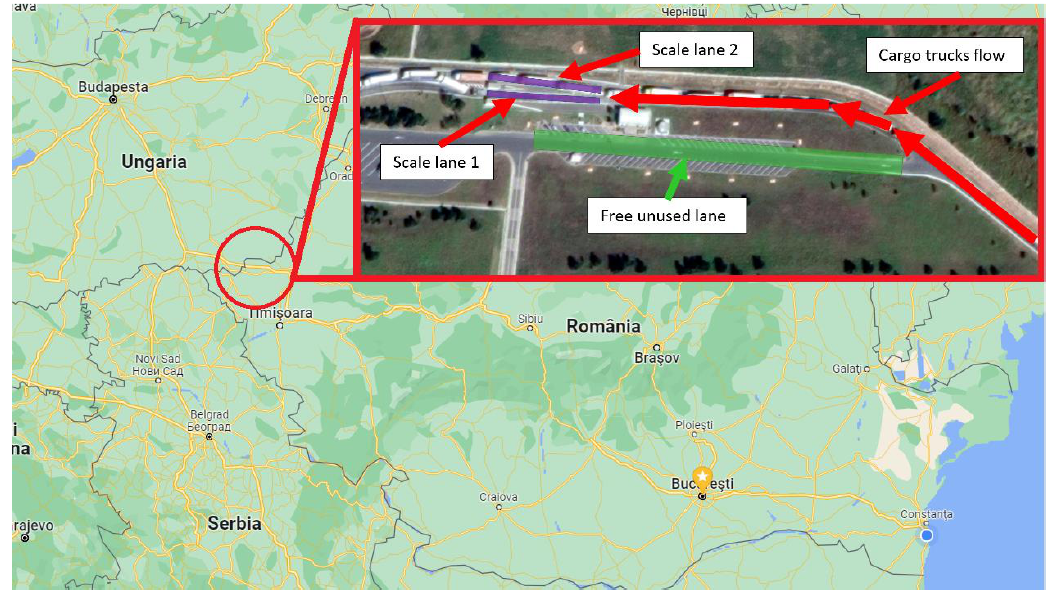
Figure 1. The position and the actual configuration of cargo vehicle flows in BCP